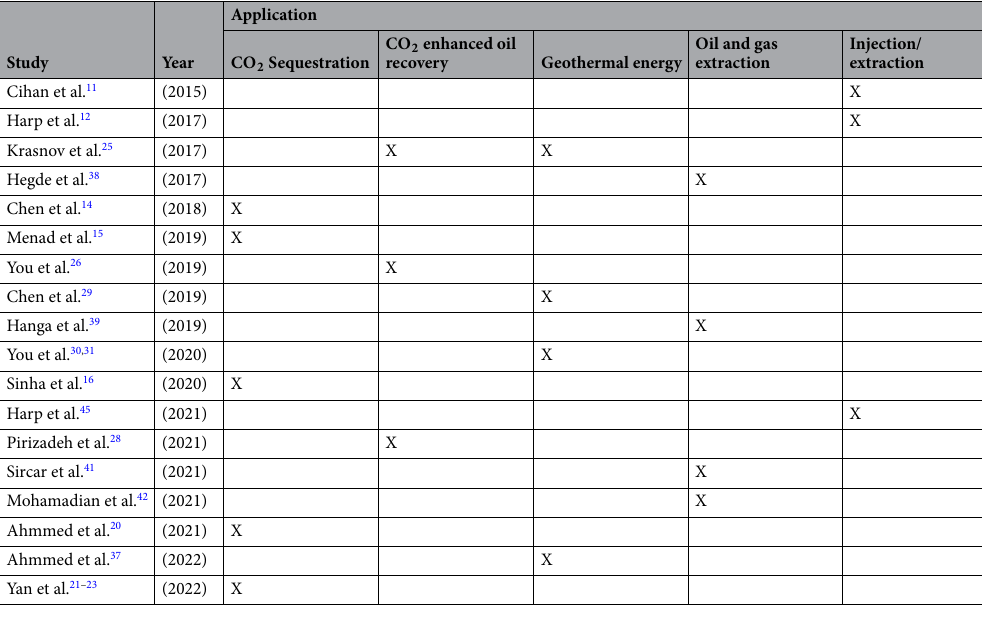
Table 1. Summary of the main prior studies and their application